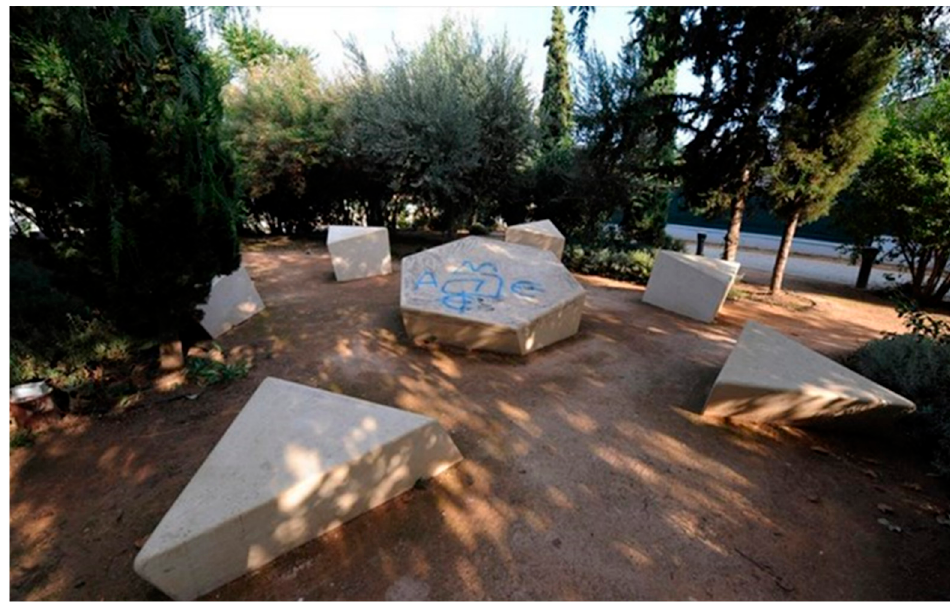
Figure 1. Vandalism of the Holocaust monument in Athens, Greece, in December 2017.